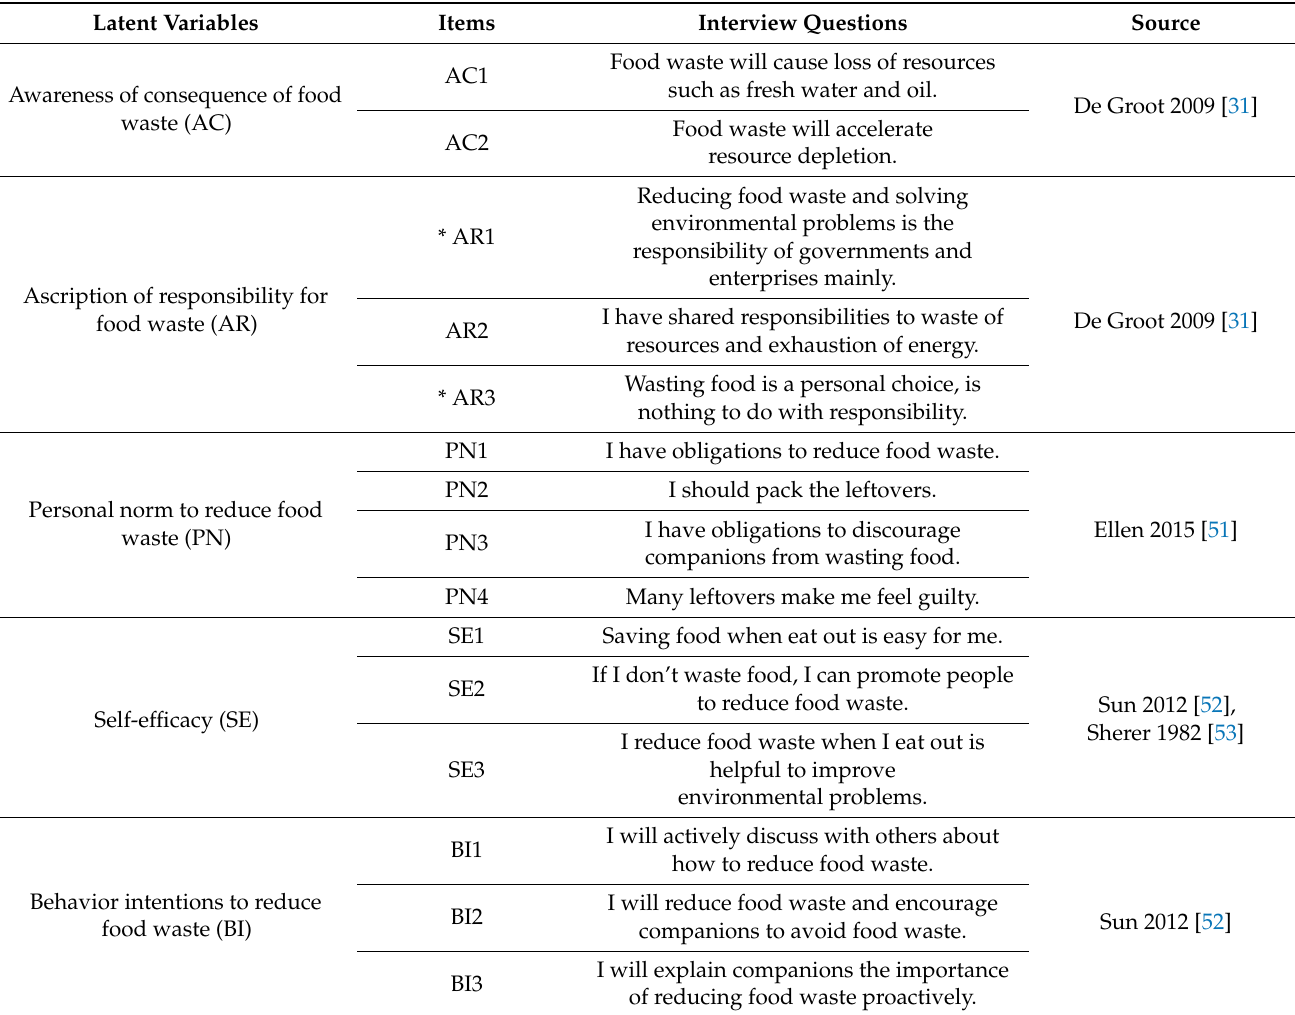
Table 1. Measurement items of latent